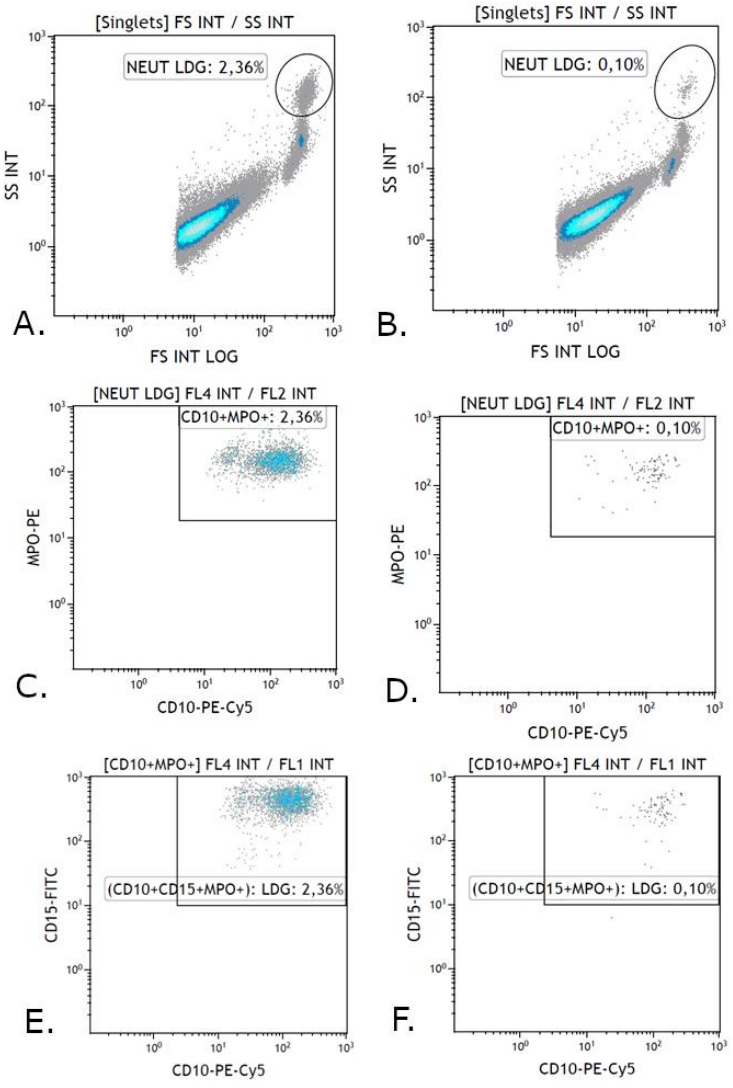
Figure 3. Exemplary analysis of the immunophenotype of LDG (CD10+ CD15+) with the expression of MPO+ antigen in patients with autoimmune hepatitis and in the control group. ( A , B ) Cytograms. Percentage of single cells relative to FSC detector and SSC (“NEUT LDG Gate”). ( C , D ) Cytograms. Percentage of cells positive for CD10 antigen and MPO (“CD10+ MPO+ Gate”). ( E , F ) Cytograms. Percentage of LDG positive for antigens: CD10, CD15, MPO+ (“CD10+ CD15+ MPO+ Gate”). ( A , C , E ) Cytograms—study group. ( B , D , F ) Cytograms—control group.